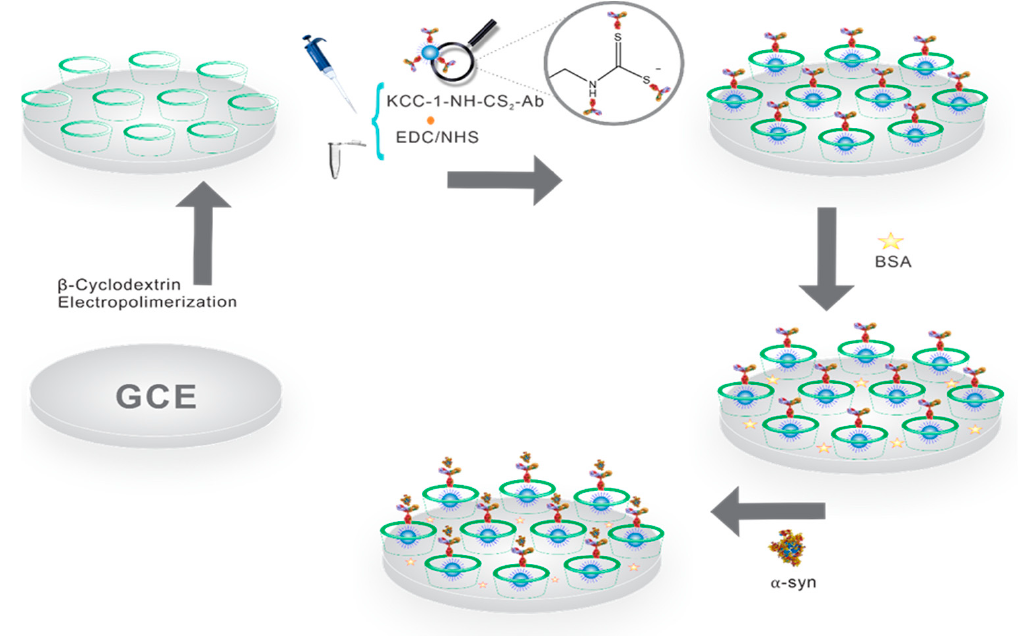
Scheme 1. The fabrication procedure of the electrochemical immunosensor for the recognition of α - syn